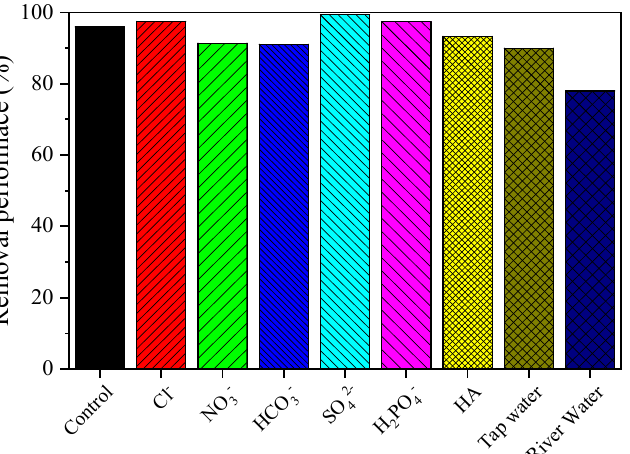
Figure 4. Influence of anions, humic acid (HA), and natural water on STZ removal. Conditions: [STZ] = 10 mg/L, [PDS] = 300 mg/L, UV irradiation: 2 mW/cm 2 , [anions] = 5 mM and [HA] = 10 mg/L.